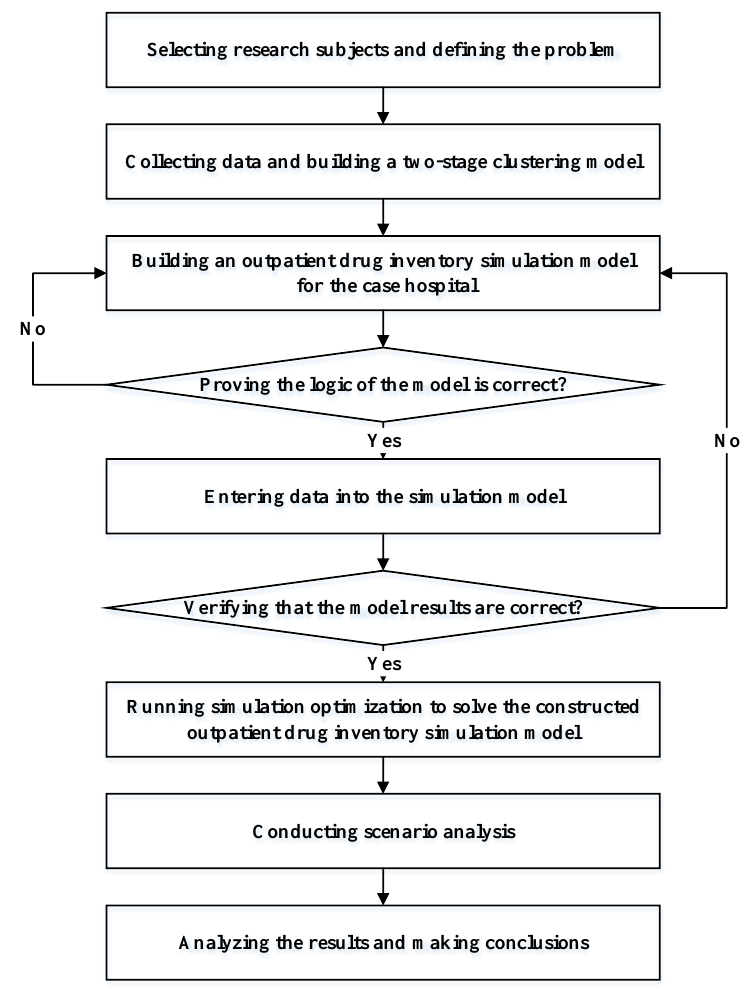
Figure 1. Research steps of this